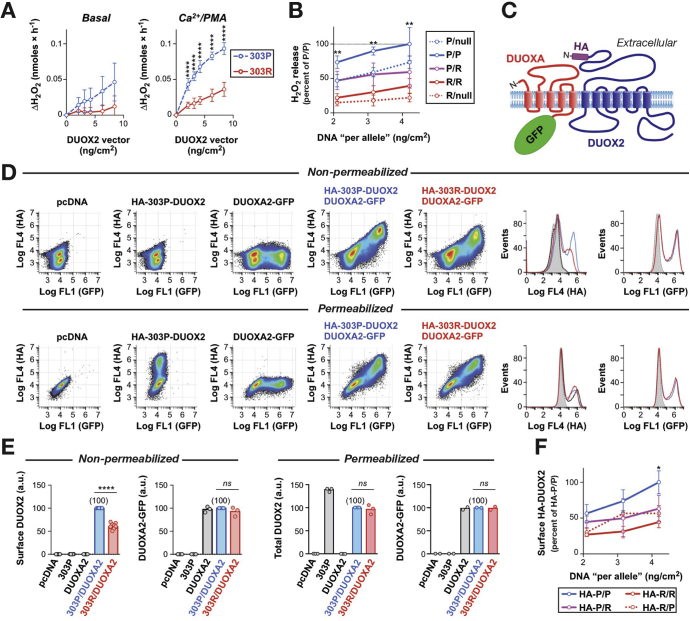
Functional characterization of the effect of DUOX2 P303R in vitro. (A) Hydrogen peroxide production from DUOXA2-reconstituted HEK293 cells transfected with 303P (wild type) and 303R DUOX2 at a range of vector concentrations. Data represent means ± SD of 3 (basal) and 6 (stimulated) independent experiments. The total amount of DNA per transfection was kept constant by adjusting with empty vector. ****P < .0001 (Student t test). (B) To simulate heterozygosity, cells were co-transfected with the indicated combinations of empty vector (null), DUOX2 303P, or 303R plasmids. Values represent means ± SD from 6 experiments per transfection dose. The activity of P/R (heterozygous 303P/303R) is significantly lower than P/P (homozygous 303P), but indistinguishable from P/null (monoallelic deletion 303P/null), P/R vs P/P: **P < .01 (analysis of variance with Sidak correction). (C) Topology model of the DUOX2/DUOXA2 complex at the plasma membrane showing the location of the introduced hemagglutinin (HA) epitope tag (DUOX2) and green fluorescent protein (GFP) fusion (DUOXA2). (D) Representative flow cytometry scatterplots and histograms showing the detection of the HA epitope and GFP fluorescence in cells transfected with the indicated plasmids. (E) Summary of DUOX2 and DUOXA2 expression assessed by flow cytometry. For each experiment (open circles), data are expressed relative to the value for the 303P/DUOXA2 transfection (set to 100). a.u., arbitrary units; ****P < .0001; ns, P > .05 (Student t test). (F) To assess the surface expression of 303P and 303R DUOX2 under heterozygous conditions, the expression of the HA epitope at the cell surface was determined in cells co-transfected with equal amounts of 2 DUOX2 plasmids, with only 1 plasmid containing an HA tag. Values represent means ± SD from 3 experiments per transfection dose. Results suggest interference of 303R with surface expression of 303P: HA-P/R vs HA-P/P: *P < .05 (analysis of variance with Sidak correction).